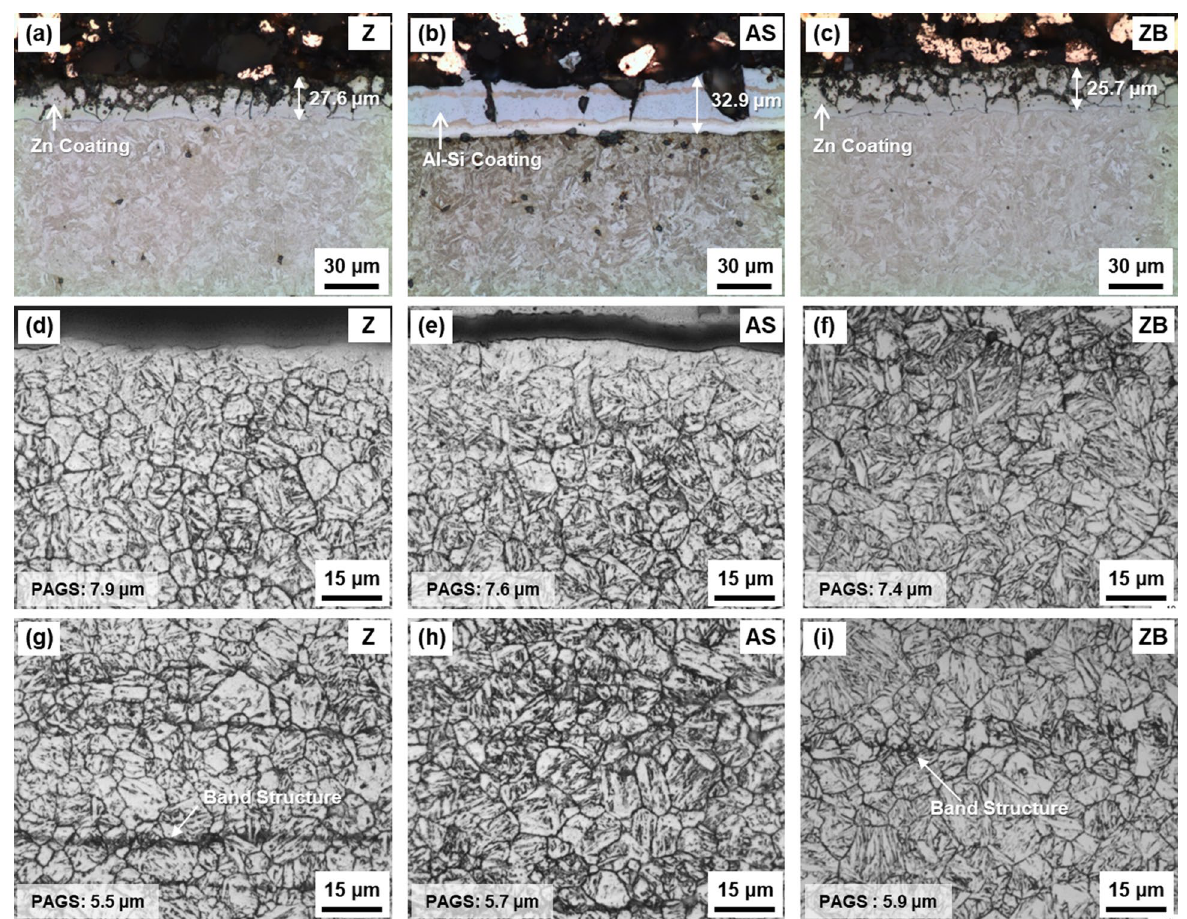
Figure 1. Optical micrographs of the ( a – c ) surface, ( d – f ) coating/steel interface, and ( g – i ) interior matrix areas of the three HPF (Z, AS, and ZB) steels. The average thickness of coating layers of the Z, AS, and ZB steels is 27.6, 32.9, and 25.7 μm, respectively. All the steels are composed of full